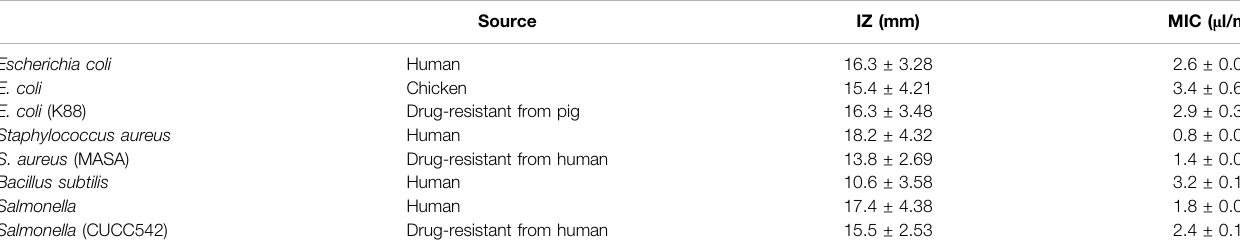
TABLE 3 | Inhibition zone and minimum inhibitory concentration of 1,8-cineole against bacteria in vitro